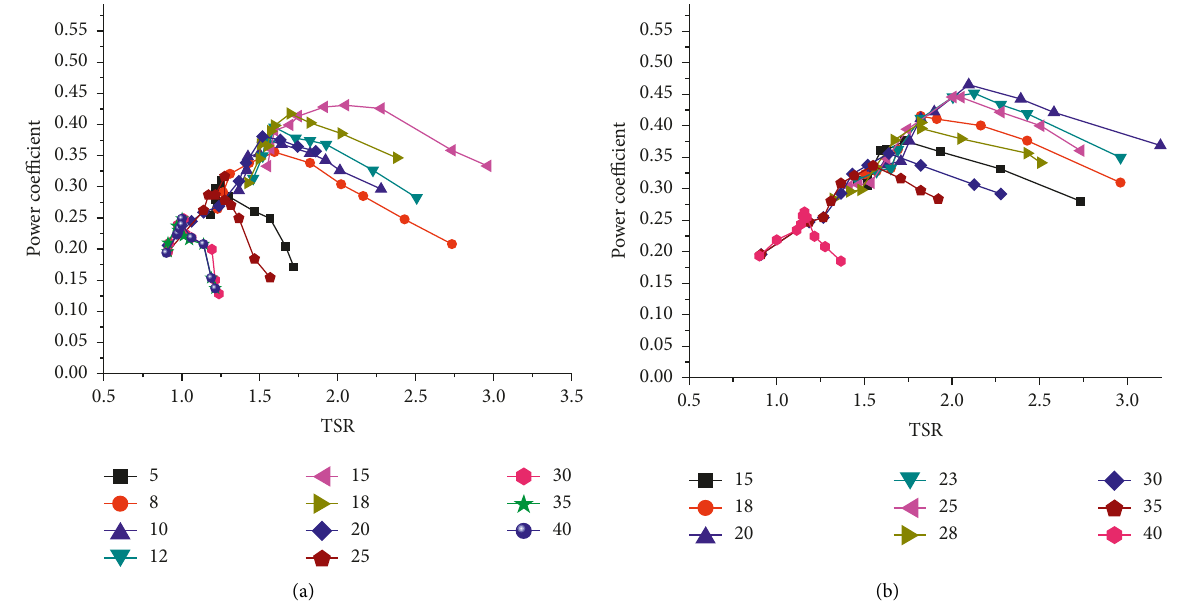
Figure 10: (a) Power coefficient versus TSR for aluminium and (b) Styrofoam blades, respectively.